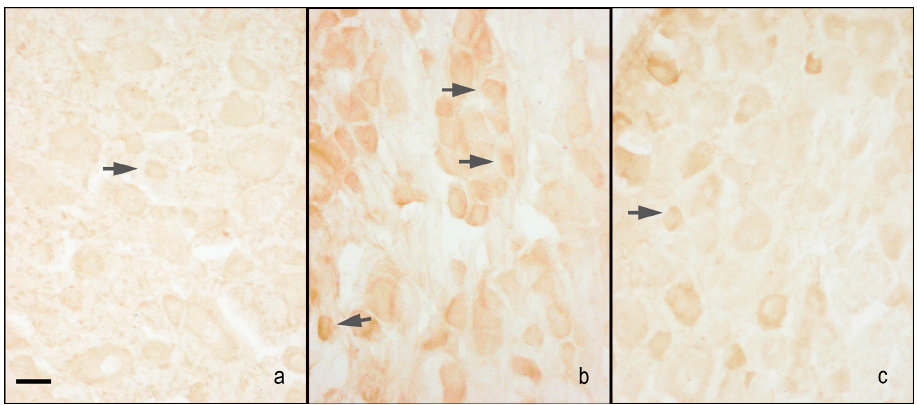
Figure 3. Microphotographs of nNOS immunostaining of the DRG. Microphotographs of nNOS immunostaining of the right DRGs of sham-operated rats treated with 1% ethanol in saline (vehicle for melatonin) ( a ), CCI animals treated with 1% ethanol in saline (vehicle for melatonin) ( b ) and CCI animals treated with melatonin 10 mg/kg ( c ). Arrows indicate small neurons. Bar = 40 µ m. iNOS Staining The iNOS immunoreactivity was localised in the cytoplasm of small size neurons, and the nuclei were virtually unstained. The CCI rats treated with 1% ethanol in saline (vehicle for melatonin) had an increase of staining compared with sham-operated rats treated with 1% ethanol in saline (vehicle for melatonin) and sham-operated rats treated with melatonin 10 mg/kg. Treatment with melatonin 10 mg/kg, but not 5 mg/kg, induced a decrease of staining in CCI rats. Moreover, the treatment with melatonin at 10 mg/kg did not affect iNOS immunopositivity in sham-operated rats compared with the administration on 1% ethanol in saline (vehicle for melatonin) (Figures 2b and 4).